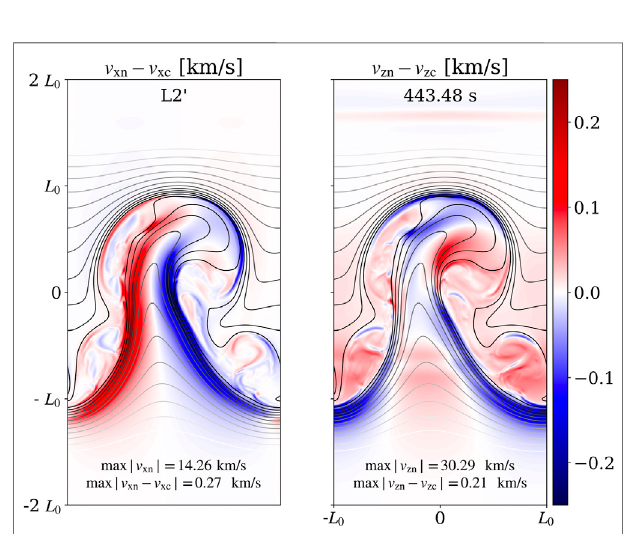
FIGURE 9 | Snapshots of the ion-neutral decoupling in horizontal and vertical velocities from a two- fl uid simulation of RTi. The image displays a close-up view of a well-developed ascending plume. The back lines are isocontours of the magnetic potential. Credit: Popescu Braileanu et al. (2021b), A&A 565, A45, reproduced with permission ©